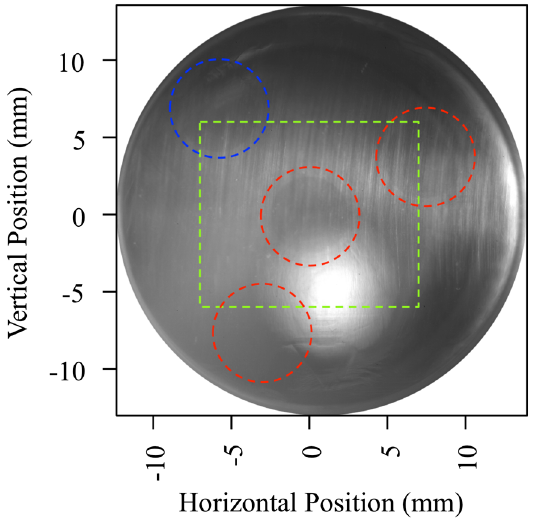
FIG. 1. Optical panorama of the CsBr photocathode installed in the gun. Red circles indicate the spots where CsBr was deposited and higher quantum efficiency was recorded. The blue circle indicates a spot where CsBr was deposited too far off axis for a beam to exit the gun. The green square indicates the area of the quantum efficiency map shown in Fig. 3. The bright area is a reflection from a lamp used to illuminate the photocathode during